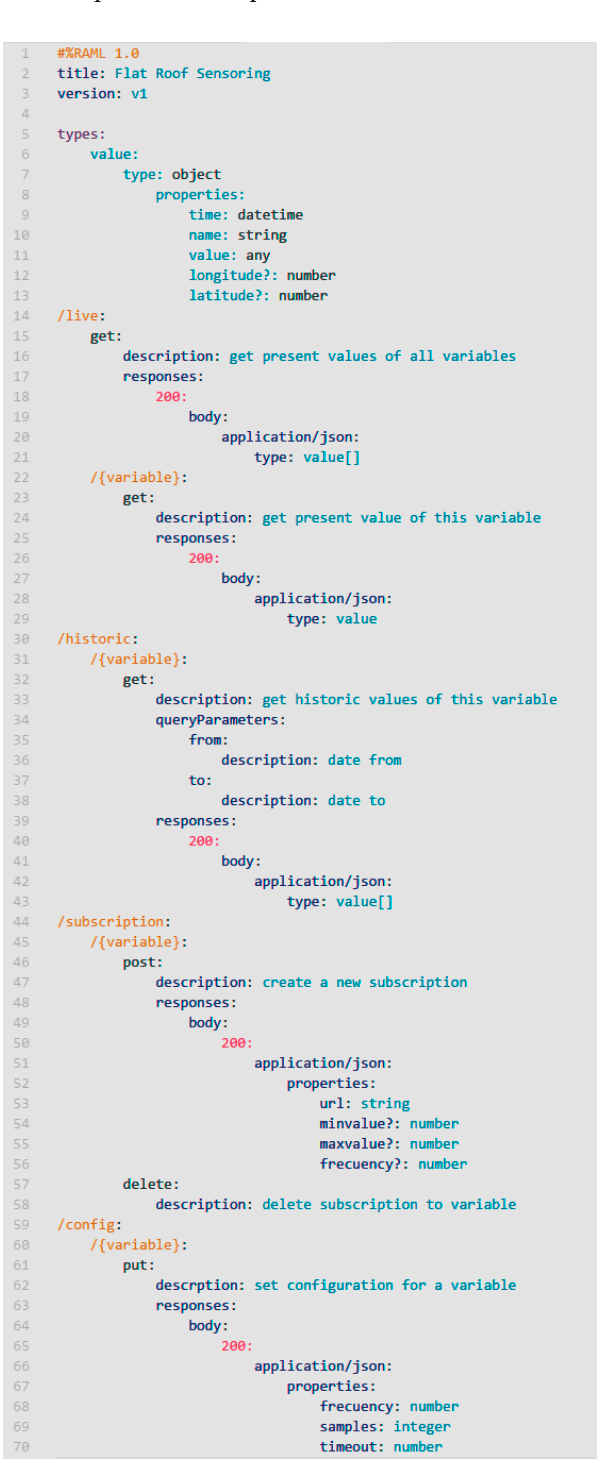
Figure 8. Monitoring flat roof service defined with RAML.